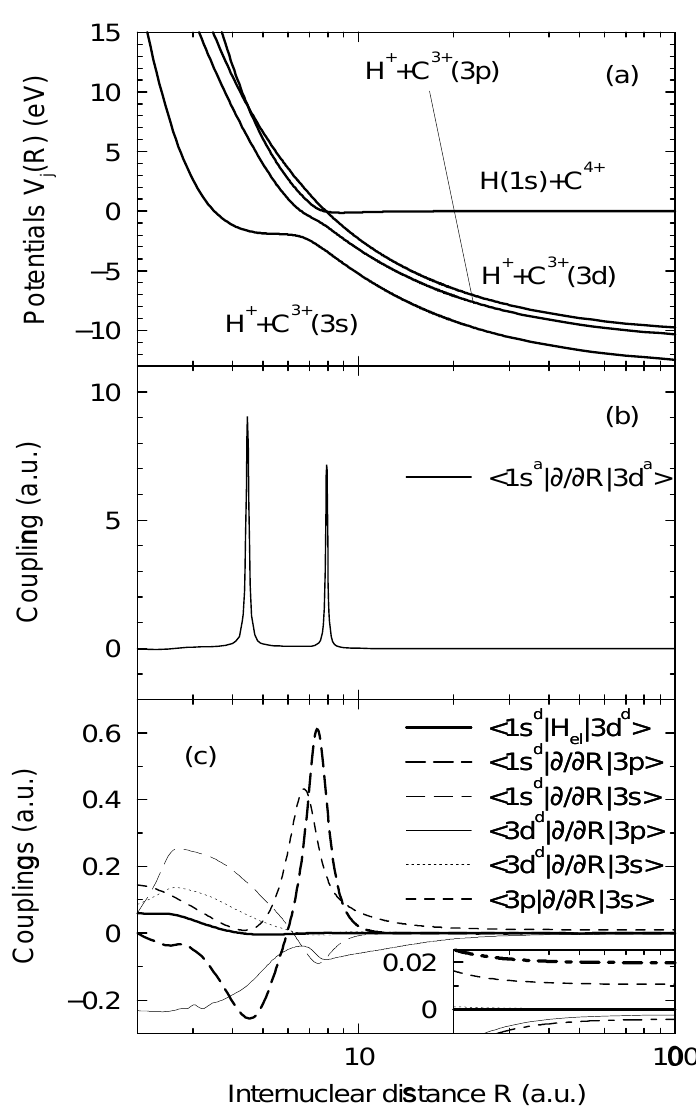
Figure 1: Quantum chemical data for the CH 4+ quasimolecule: the potentials in the partly diabatic representation (a), the nonadiabatic radial coupling matrix element (cid:104) 1 s a | ∂/∂R | 3 d a (cid:105) (b), and the couplings in the party diabatic representation (c). The insert in (c) shows the couplings in the enlarged scale and demonstrates that some of them do not vanish as R → ∞ . The thick and thin dot-dashed lines are the (cid:104) 3 p | ∂/∂R | 3 s (cid:105) and (cid:104) 3 d | ∂/∂R | 3 p (cid:105) nonadiabatic matrix elements for the CD 4+